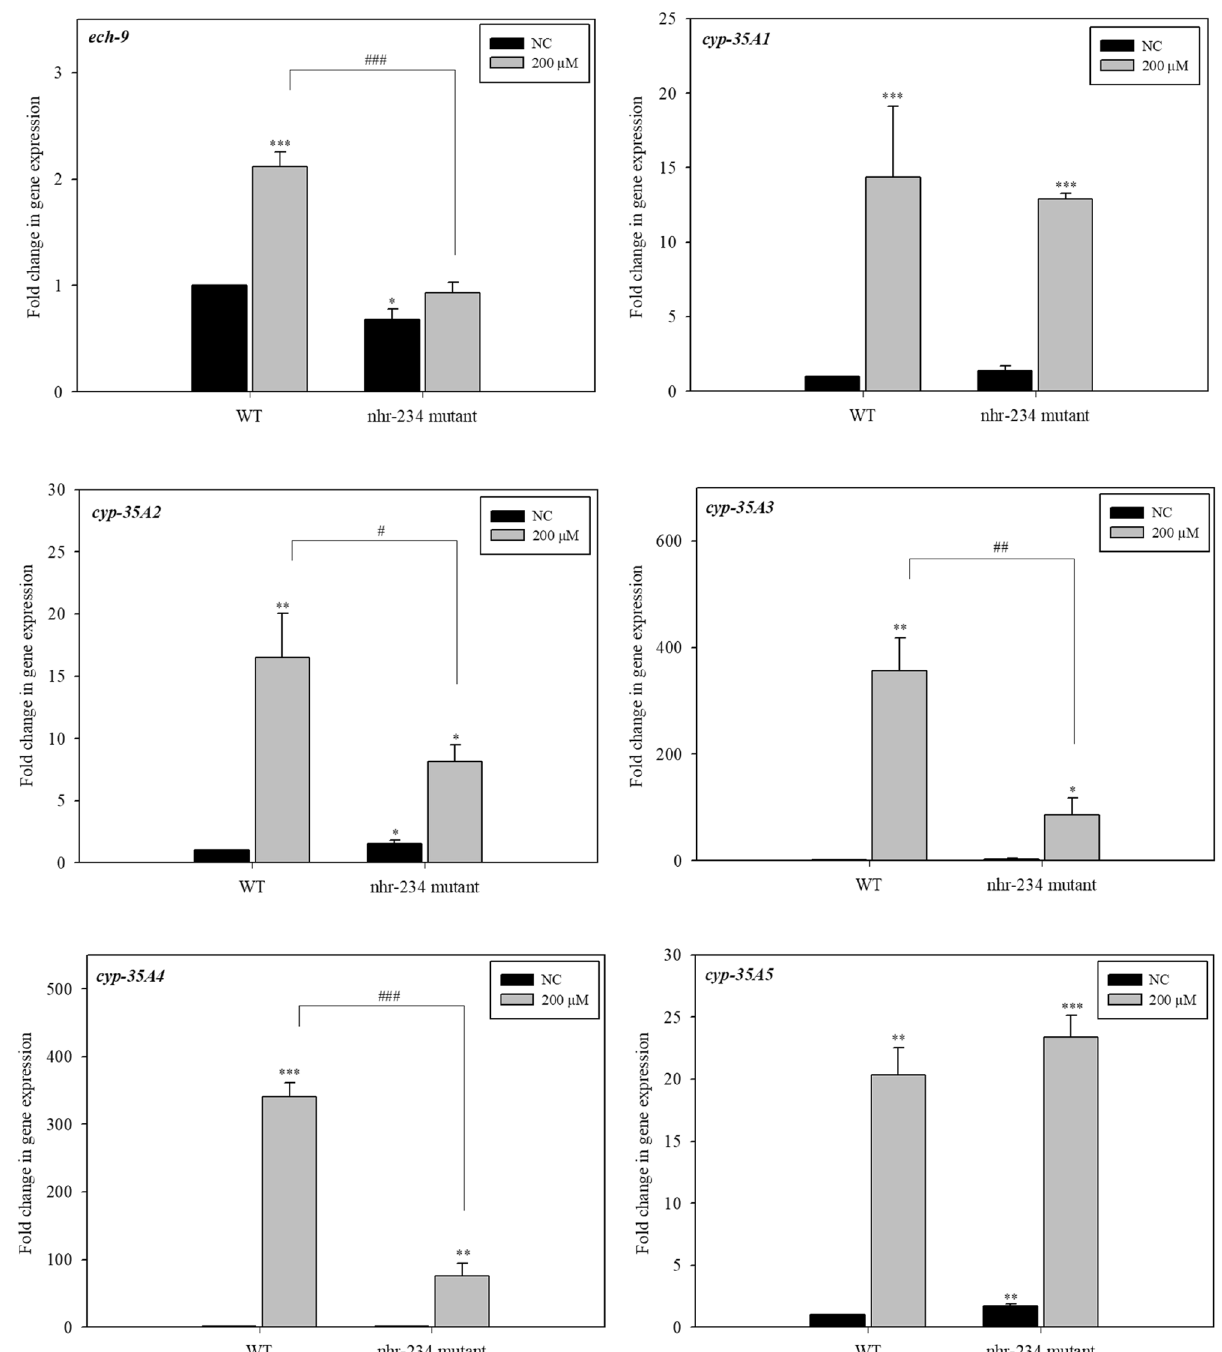
Figure 5. Expression levels of ech-9 and cyp-35A subfamily members in wild-type (N2) (WT) and nhr-234 mutant C. elegans . The worms were grown on NGM plates containing 0 µM and 200 µM remofuscin for 5 days, and the gene expression levels were measured by qPCR. The experiments were independently conducted at least three times. * p < 0.05, ** p < 0.01, *** p < 0.001, Student’s t-test, compared with the wild-type (N2) NC (0 μM remofuscin) and ### p < 0.001, Student’s t-test, compared with the 200 µM remofuscin-treated wild-type (N2)